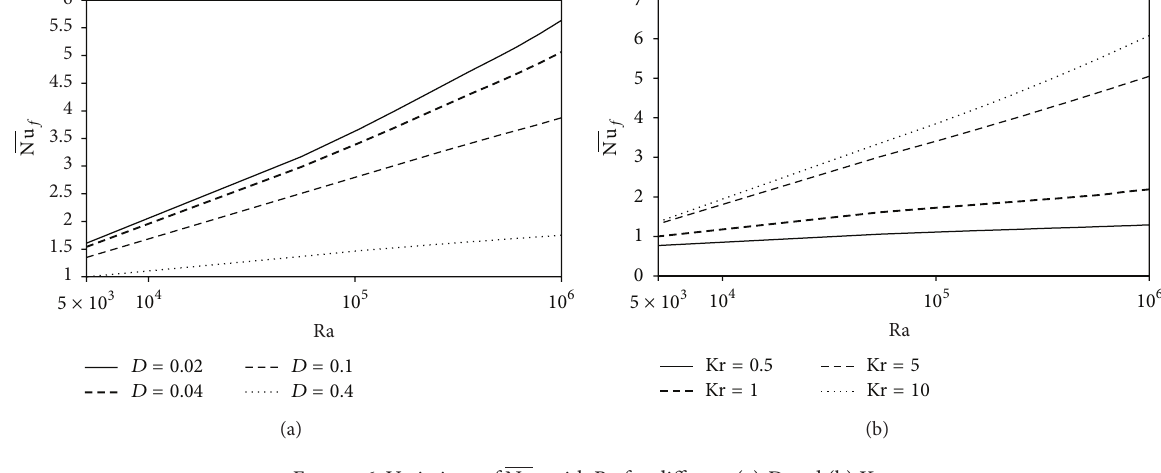
Figure 6: Variations of Nu 𝑓 with Ra for different (a) 𝐷 and (b) Kr.